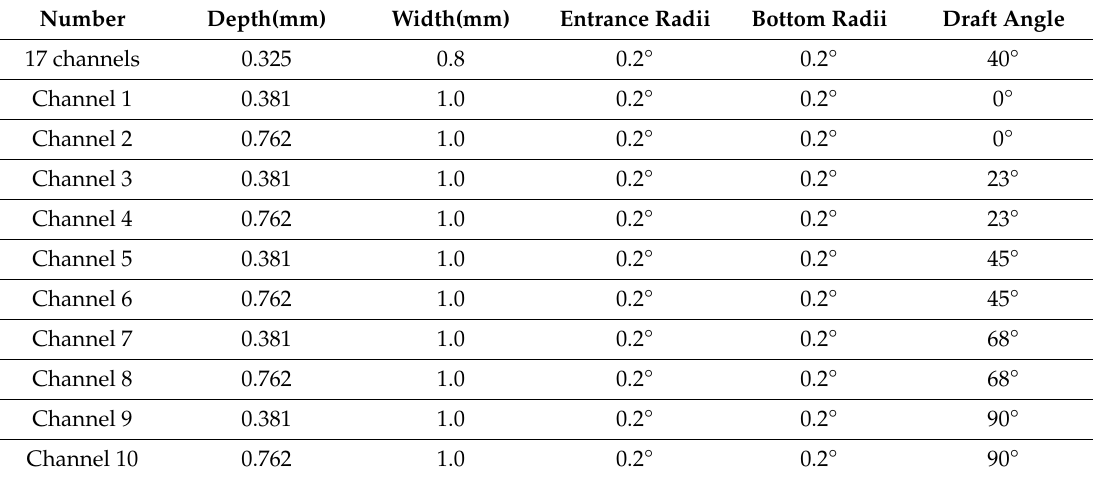
Figure 5. ( a ) The bipolar plate die, ( b ) the 10-channel die, and ( c ) the parameters describing a channel. Table 1. The dimensions of the bipolar plate die and 10-channel die.